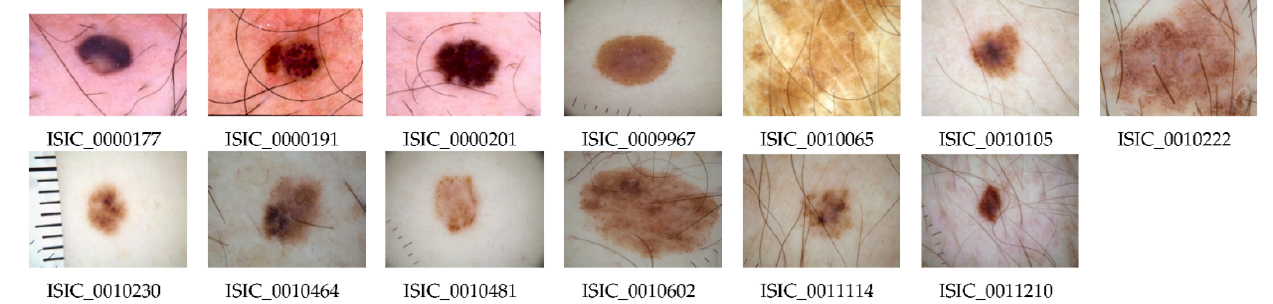
Figure 9. Image dataset sH-data selected randomly from H-data .